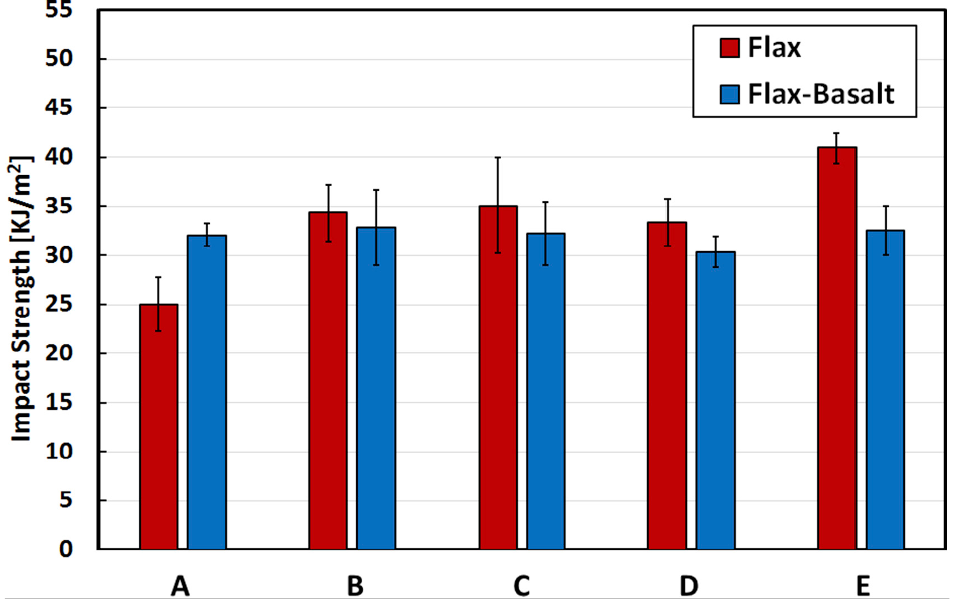
Figure 16. Impact strength for flax and flax – basalt composites [226] (reprinted with permission from Elsevier, Licence Number: 5447080120537).